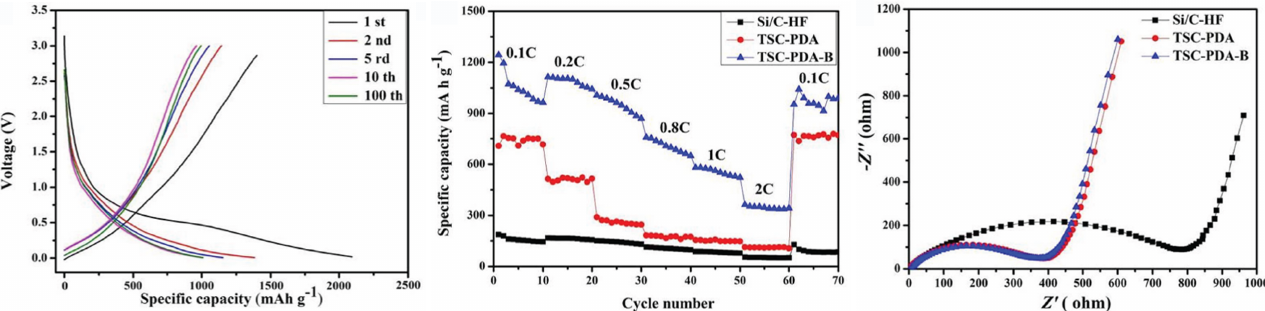
Figure 21. Yolk-Shell SiC composite anodes-single carbon layer (Si/C-HF), double carbon layer with single Si core (TSC- PDA), and double carbon layer with broken Si cores (TSC-PDA-B): Charge/discharge curves for TSC-PDA-B, rate capability, and Nyquist plots, for all anode types. Reproduced with permission